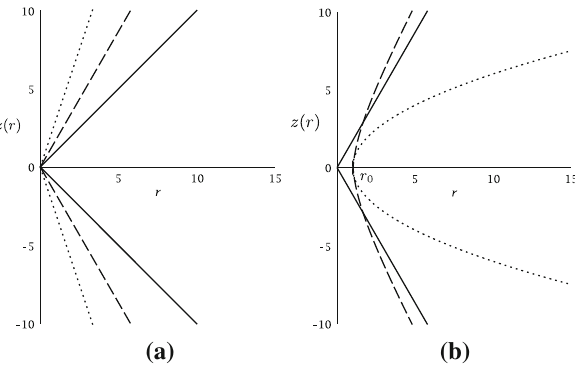
Fig. 1 Plot a shows embedding diagrams of the metric (7) for slices , 3 , 9 t = const ,θ = π and β = 1 (solid, dashed and dotted lines, 2 2 4 10 respectively). All slices exhibit a conical singularity due to the solid angle deficit of the metric (7). Plot b shows embeddings for Eqs. (6) and(7)(dashedandsolidlines,respectively)with β = 3 / 4. For r → ∞ the distance between dashed and solid curves approaches zero. The dotted line represents the embedding of (6) with β = 0